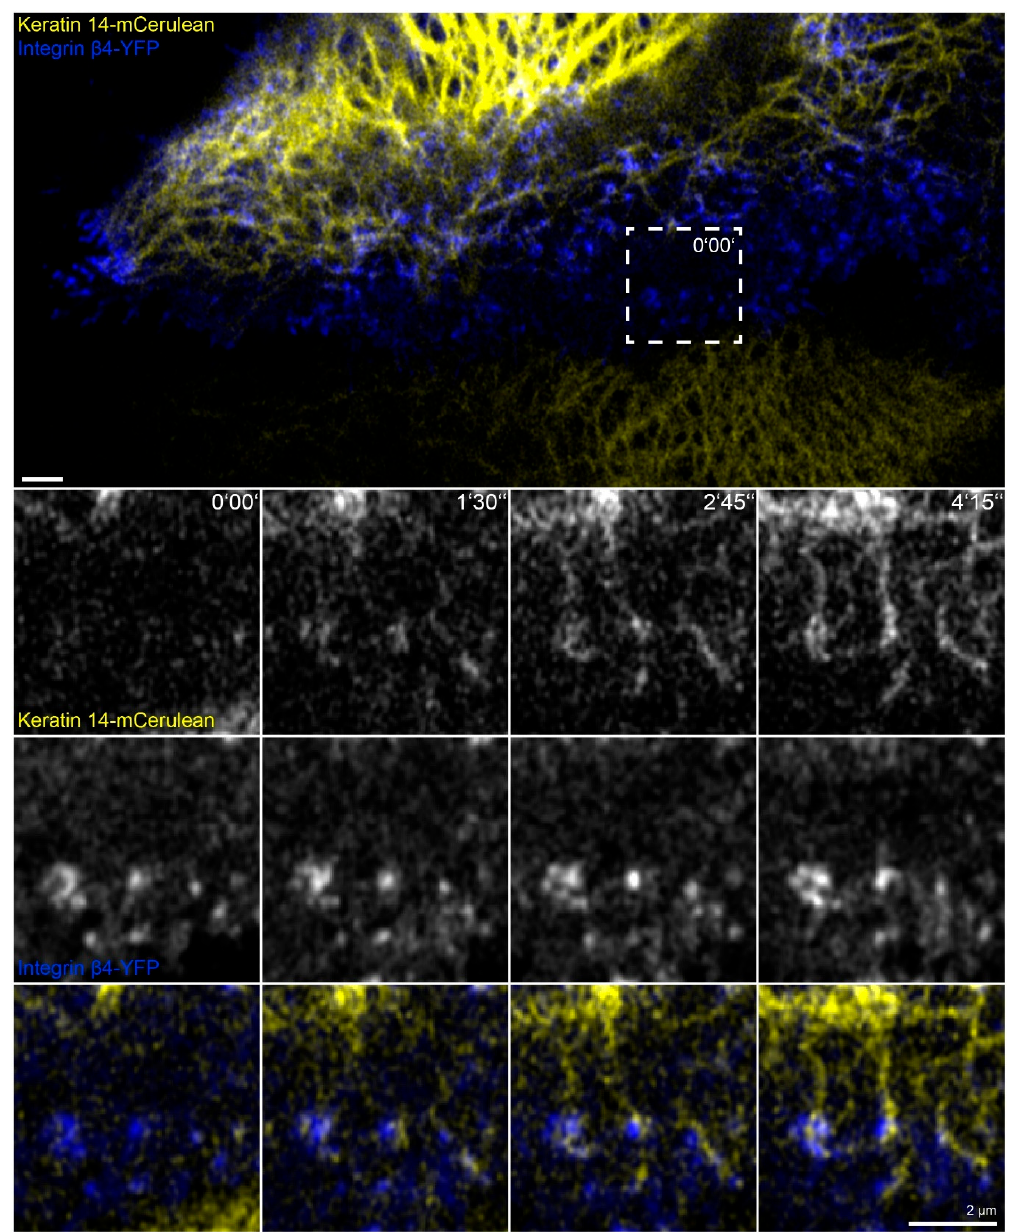
Figure 7. Keratin filaments are assembled at and interconnect hemidesmosomes in migrating cells. The fluorescence images depict the distribution of keratin 14-mCerulean and integrin β 4-yellow fluorescent protein (integrin β 4-YFP) in a migrating HaCaT cell that is next to another cell, which is only positive for keratin 14-mCerulean. Note that both cells are surrounded by non-transfected cells. The magnified time series recorded in the square delineated by a broken line shows different stages of keratin filament assembly at nascent hemidesmosomal integrin β 4-YFP clusters. The growing filaments interconnect hemidesmosomes and gain contact with the peripheral keratin cytoskeleton. All images were recorded at the bottom focal plane (n=20, all cells were migrating). The entire time-lapse series is shown in Video S7.